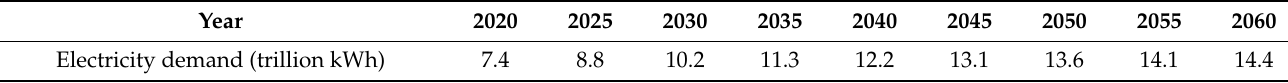
Table 12. Prediction of future electricity demand in China.